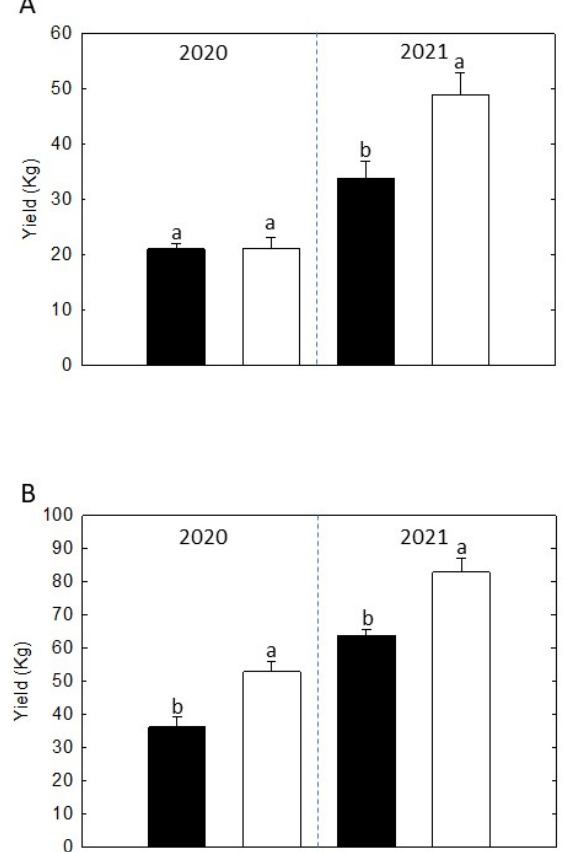
Figure 6. Yield in Hamlin ( A ) and Valencia ( B ) scions grafted on Swingle( ■ ) and US-942 ( □ ) root- stocks. Data are means of four biological replicates. Error bars represent standard errors. Means with the same letter are not significantly different from each other at p -value < 0.05 according to Tukey – Kramer.